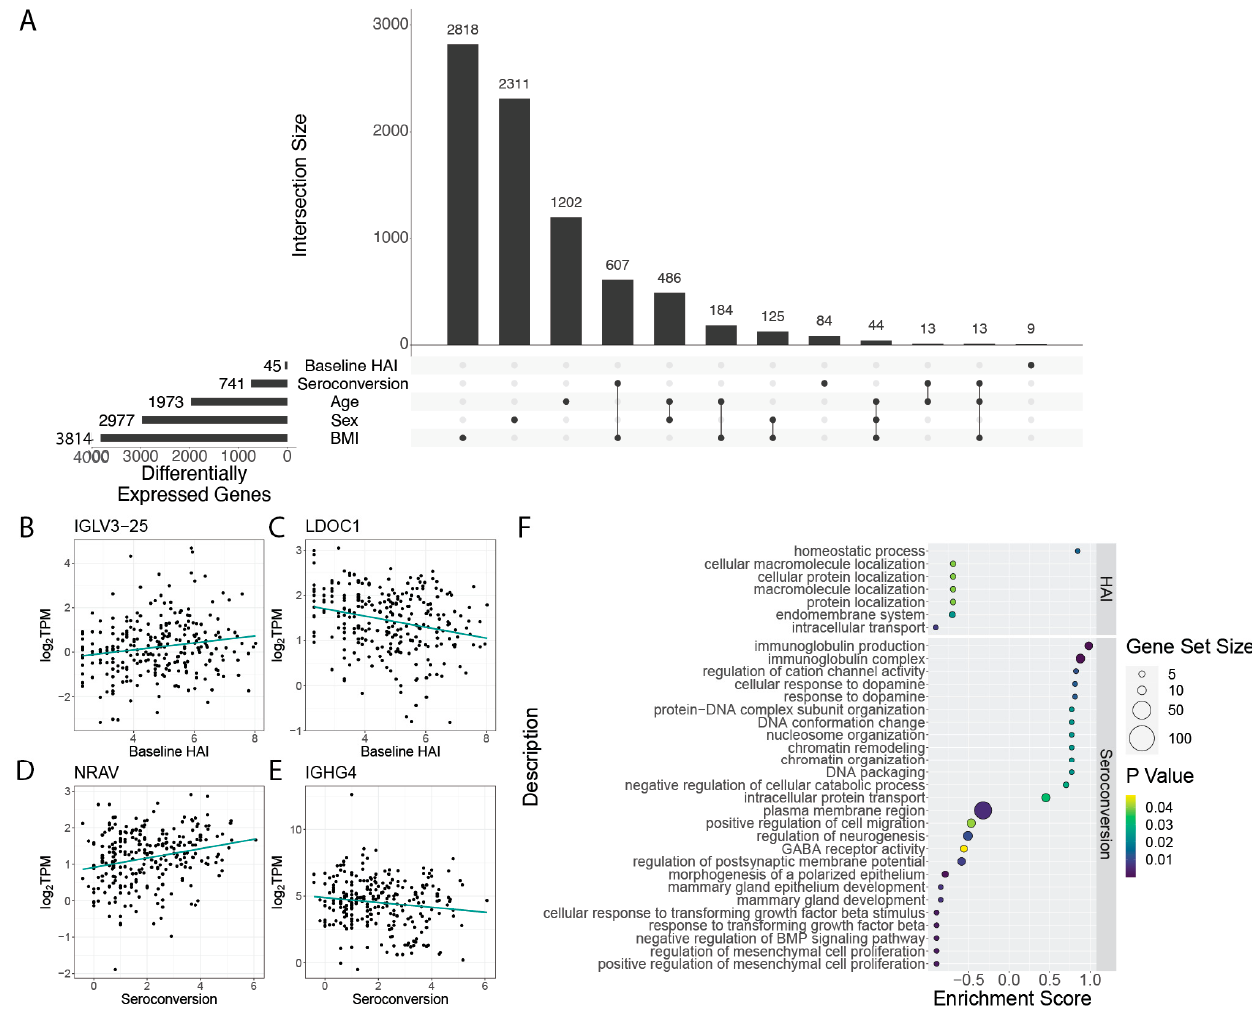
Figure 2. Differential gene expression analysis of pre-existing immunity and vaccine response. ( A ) Genes that are differentially expressed with variation in baseline HAI and seroconversion. An UpSet plot shows the top 12 subsets ranked by size of differentially expressed genes grouped by physiological features. Sets of genes differentially expressed with two or more variables are con- nected by lines. Representative genes with ( B ) increased and ( C ) decreased expression in participants with higher baseline HAI. Representative genes that are ( D ) increased and ( E ) decreased in participants with higher seroconversion. ( F ) Gene function enrichment using GSEA of the 45 genes differentially expressed with baseline HAI ( top ) and the 741 genes differentially expressed with seroconversion ( bottom ). Note that the histogram in panel ( A ) has been truncated for values less than 9 for visualization purposes.